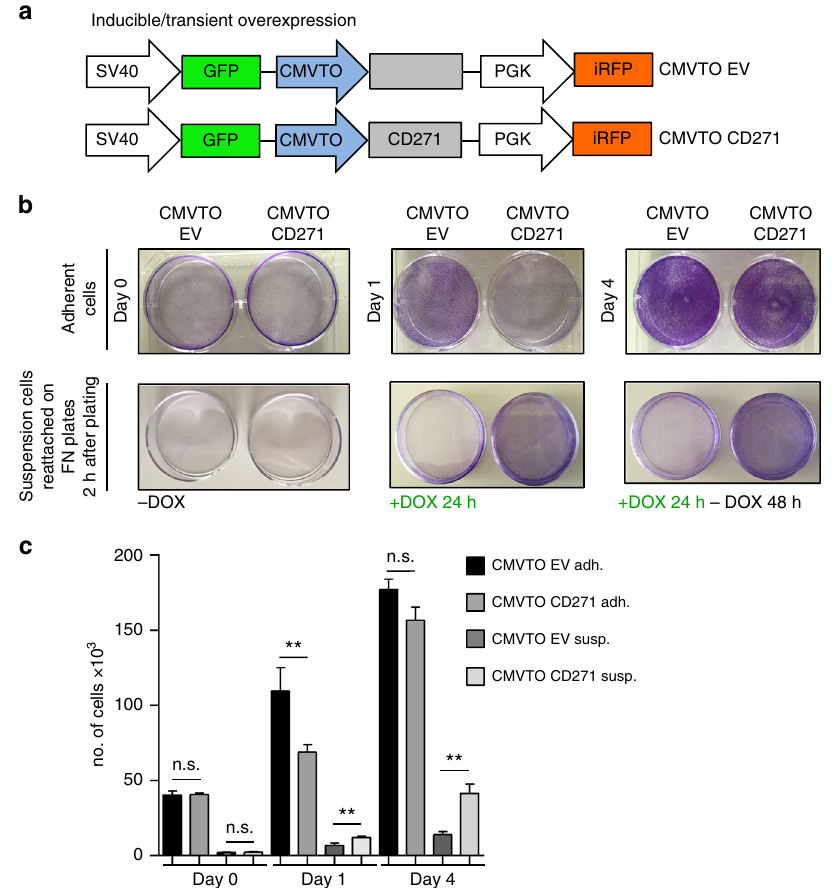
Fig. 4 CD271 transient overexpression in vitro reveals a reversible phenotype. a Schematic representation of the inducible vector (TetON) to overexpress CD271 in melanoma cell lines. The viral backbone carries the green fl uorescent protein (GFP) and infrared fl uorescent protein (iRFP) reporters under the SV40 and PGK promoters respectively, as well as the CD271 overexpression cassette (CMVTOCD271) or an empty vector (CMVTOEV) under the inducible CMVTetOperon (CMVTO) promoter. The overexpression of the gene is controlled by doxycycline and is based on the TRex TM system (pLenti CMV TetR Blast, Addgene no. 17492). b Crystal violet staining of adherent cells (upper panels) and suspension cells forced to reattach on fi bronectin- coated plates (lower panels). Not treated (day 0), treated with doxycycline for 24 h (day 1), and subsequently released from doxycycline for 48 h (day 4). c Quanti fi cation of cell numbers of b ( n = 3, P values > 0.05, ≤ 0.01). Error bars indicate S.D. All experiments done with cell line